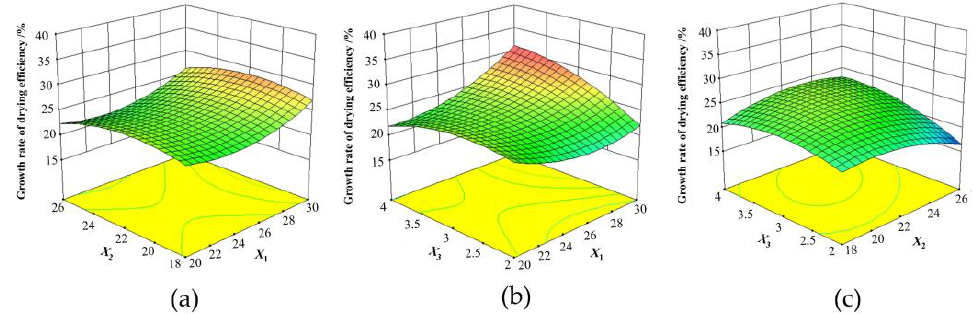
Figure 6. Growth rate of drying efficiency: ( a ) moisture content of Cyperus esculentus at the beginning of tempering and tempering temperature; ( b ) tempering duration and tempering temperature; ( c ) tempering duration and moisture content of Cyperus esculentus at the beginning of tempering.